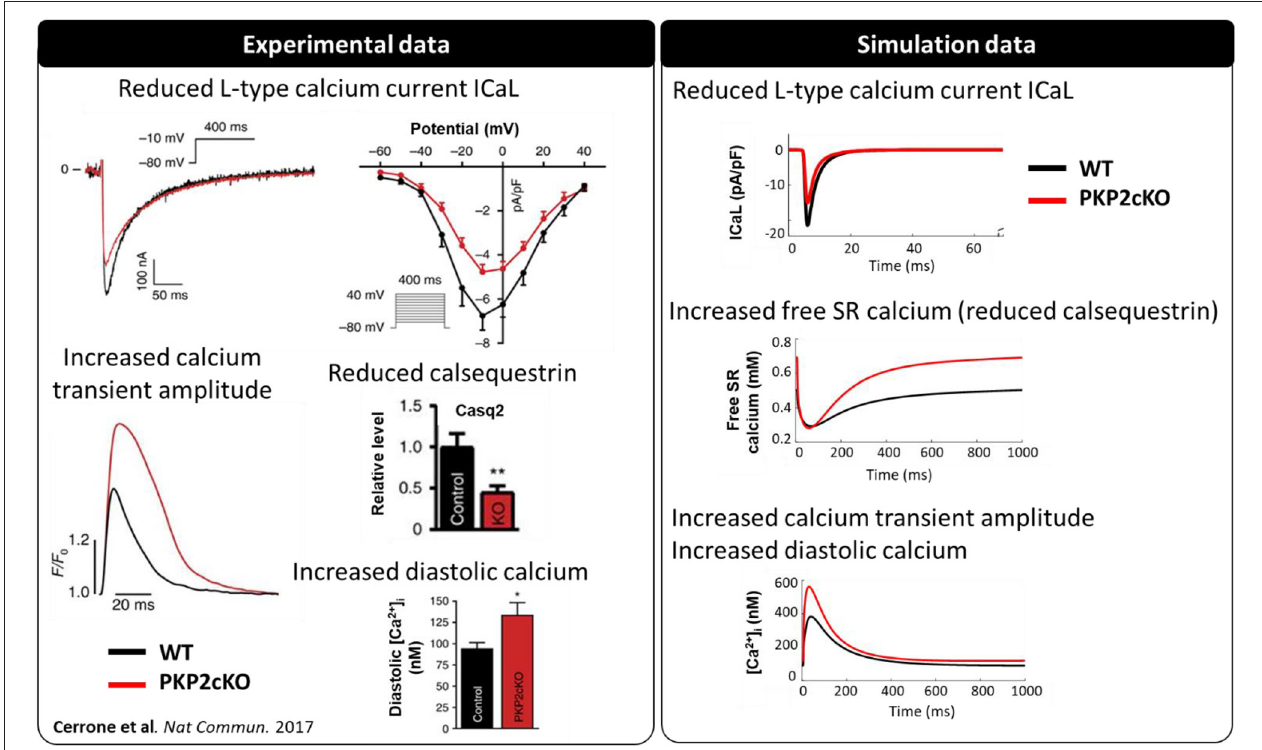
FIGURE 2 | Calcium-handling properties [L-type calcium current (I Ca,L ), calsequestrin protein levels, calcium transient and diastolic calcium concentrations] measured experimentally (modified from Cerrone et al., 2017) ( ** p < 0.01) in wildtype (WT) (black) and PKP2-cKO (red) cardiomyocytes (left), and corresponding simulated data